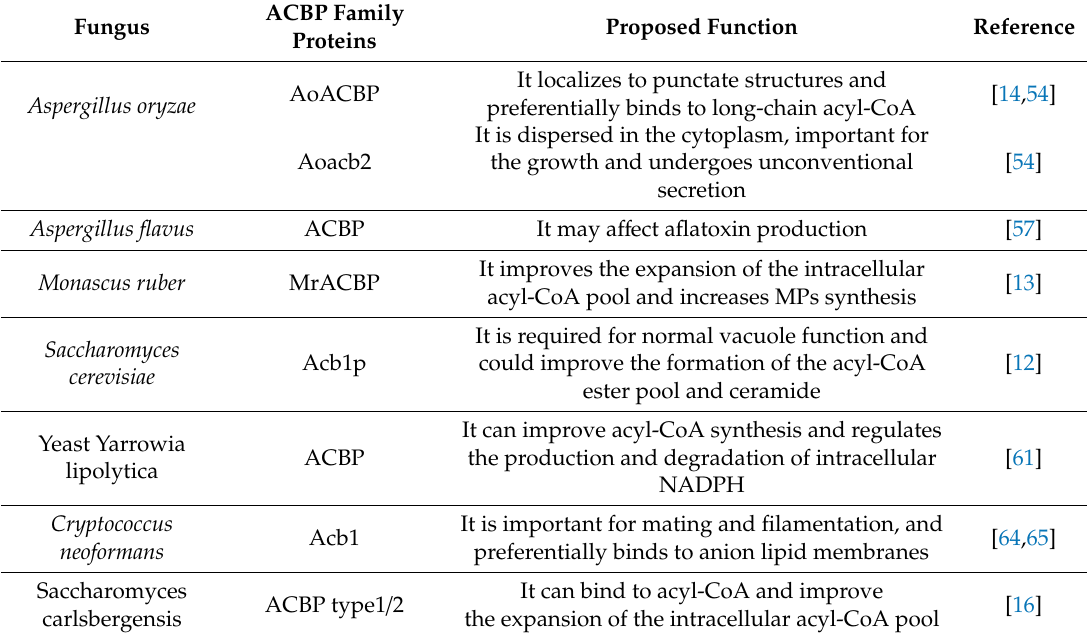
Table 1. The proposed function of Acyl-CoA-binding protein (ACBP) from filamentous fungi and yeast. Fungus